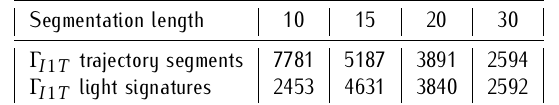
Table 12. Number of light intensity segments and unique light signatures with various segmentation lengths for Deva to Bucures ti (via Sibiu) trajectory ,